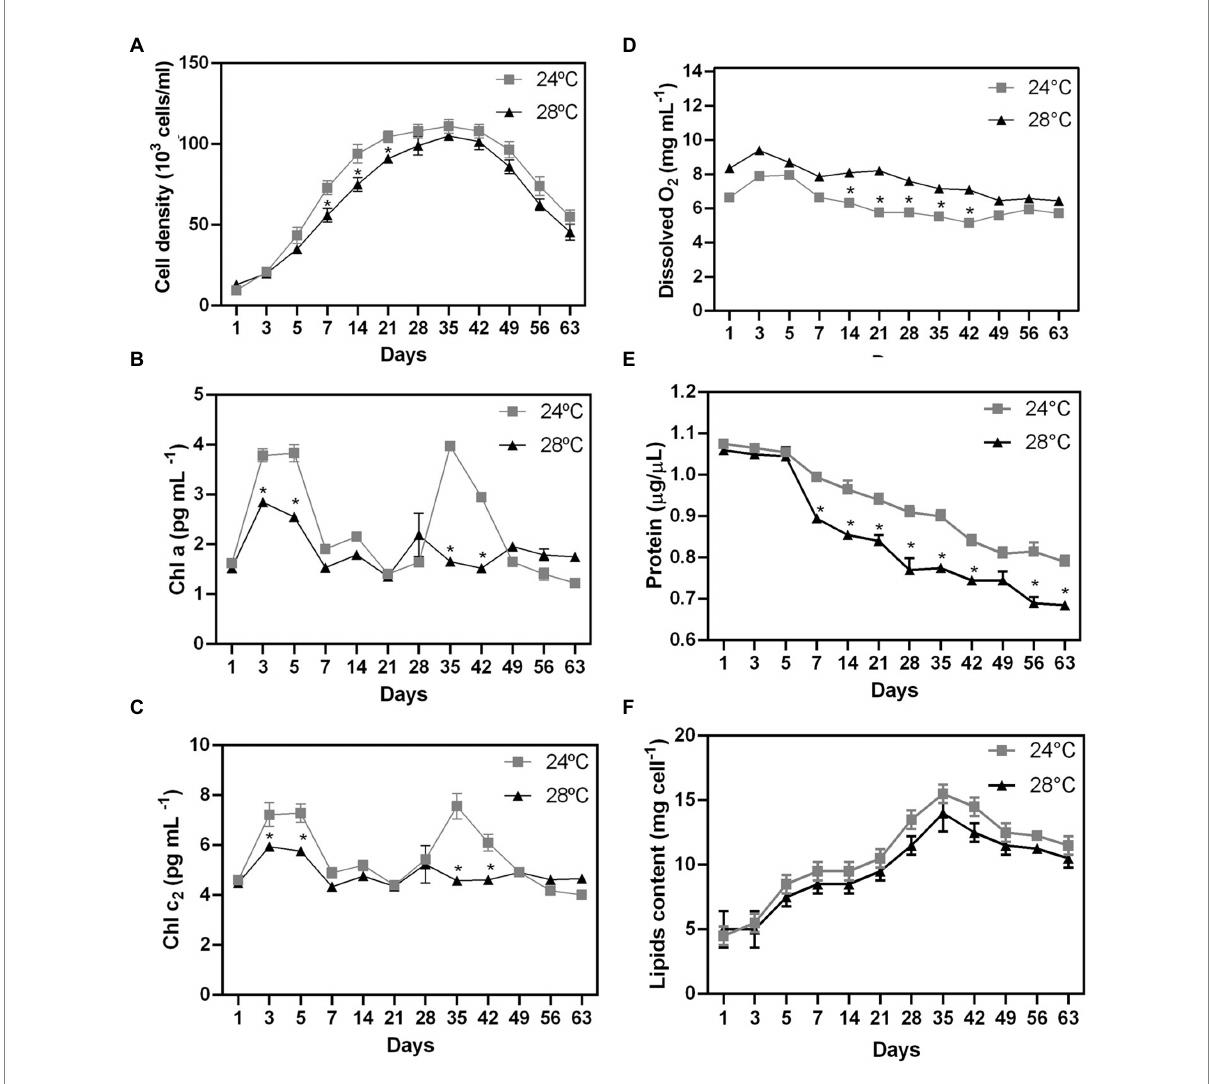
FIGURE 1 Biochemical changes during stress heated on different days in Cladocopium cells. To verify the effect of temperature on cellular biochemistry, CCMR093 cells cultured at 24 ° C and 28 ° C were submitted to analysis of growth curve (A) , pigments -Chla and chlc 2 (B,C) , oxygen (D) , biomolecules-protein (E) and lipids (F) . Data are presented as the mean ± standard errors of the results of two independent experiments. Some error bars are obscured by data point markers. The statistical difference ( t -Test) between bleaching (28 ° C) and control (24 ° C) is indicated as * p <